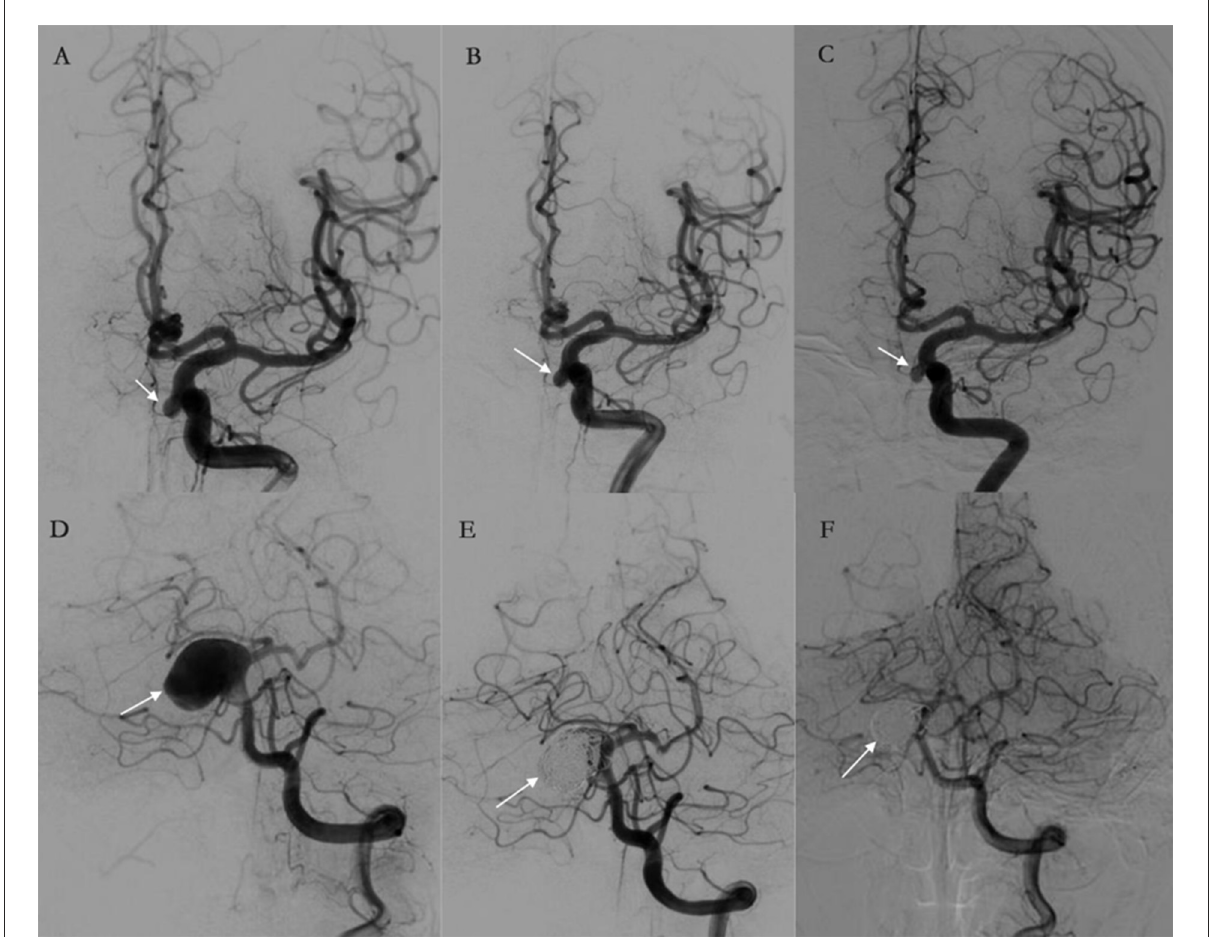
FIGURE1 (A–F) Illustrations of angiographic results in a case treated by the Tubridge flow diverter (TFD) alone (A–C) and a case treated by TFD combined with coiling (D–F) . The arrows point to target aneurysms. (A–C) An aneurysm treated by TFD alone at pre-treatment, post-treatment, and follow-up. The angiography results show that the aneurysm was incompletely occluded and are classified as Raymond III at 6 months. (D–F) An aneurysm treated by TFD combined with coiling at pre-treatment, post-treatment, and follow-up. The angiography results show complete aneurysm occlusion during a 6-month